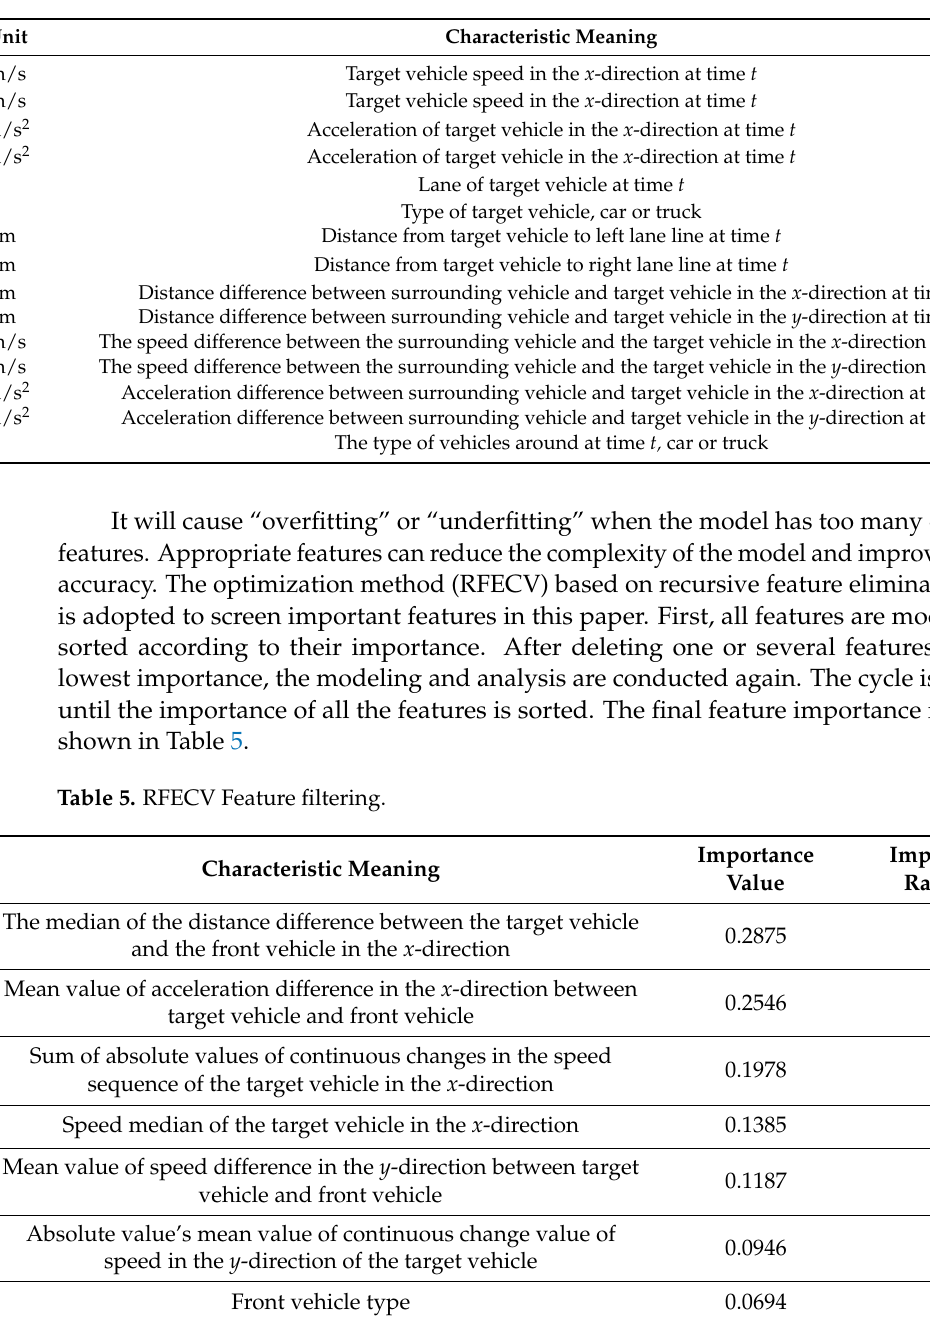
Table 4. Driving style classification model features.